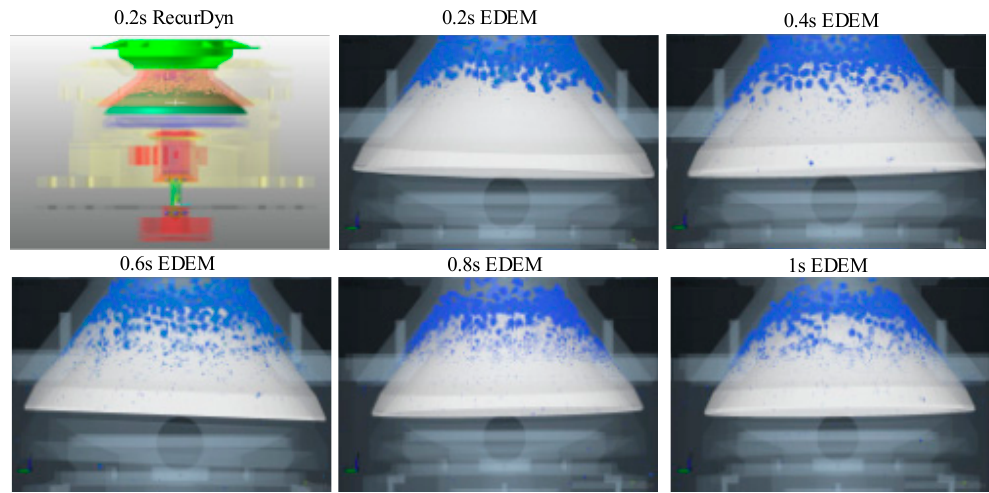
Figure 14. Series of pictures from MBD–DEM simulations with the bond cluster.